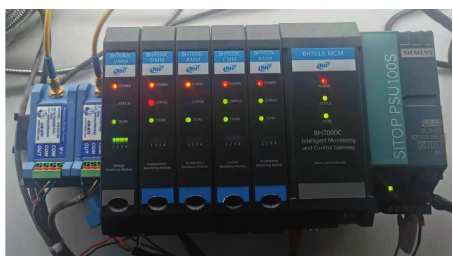
Figure 6: Data acquisition equipment.